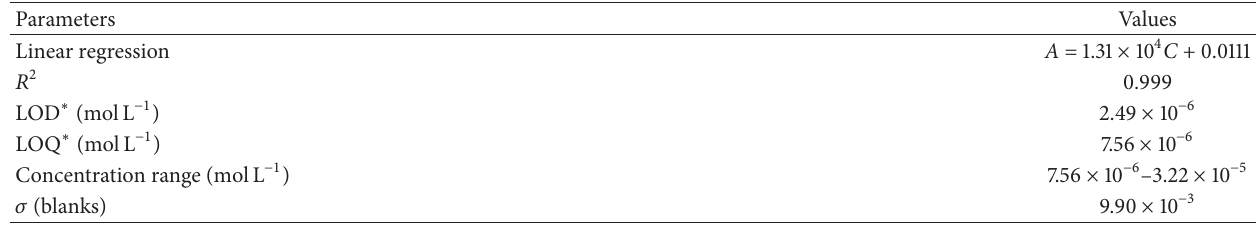
calculated . Table 5: Analytical parameters for the AOF determination using a calibration curve in tap water. Parameters Values Linear regression A = 1.31 × 10 4 C + 0.0111 𝑅 2 0.999 LOD ∗ (molL −1 )